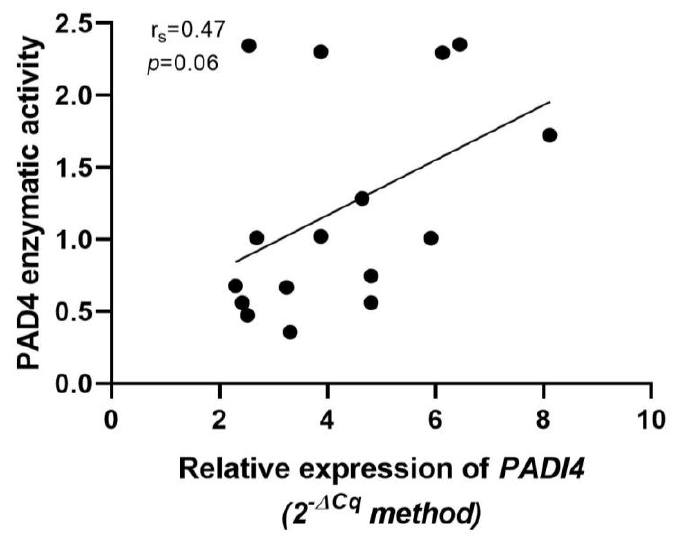
Figure 6. Correlation of mRNA PADI4 expression with PAD4 enzymatic activity. The p -value was calculated by the Spearman correlation (rs).